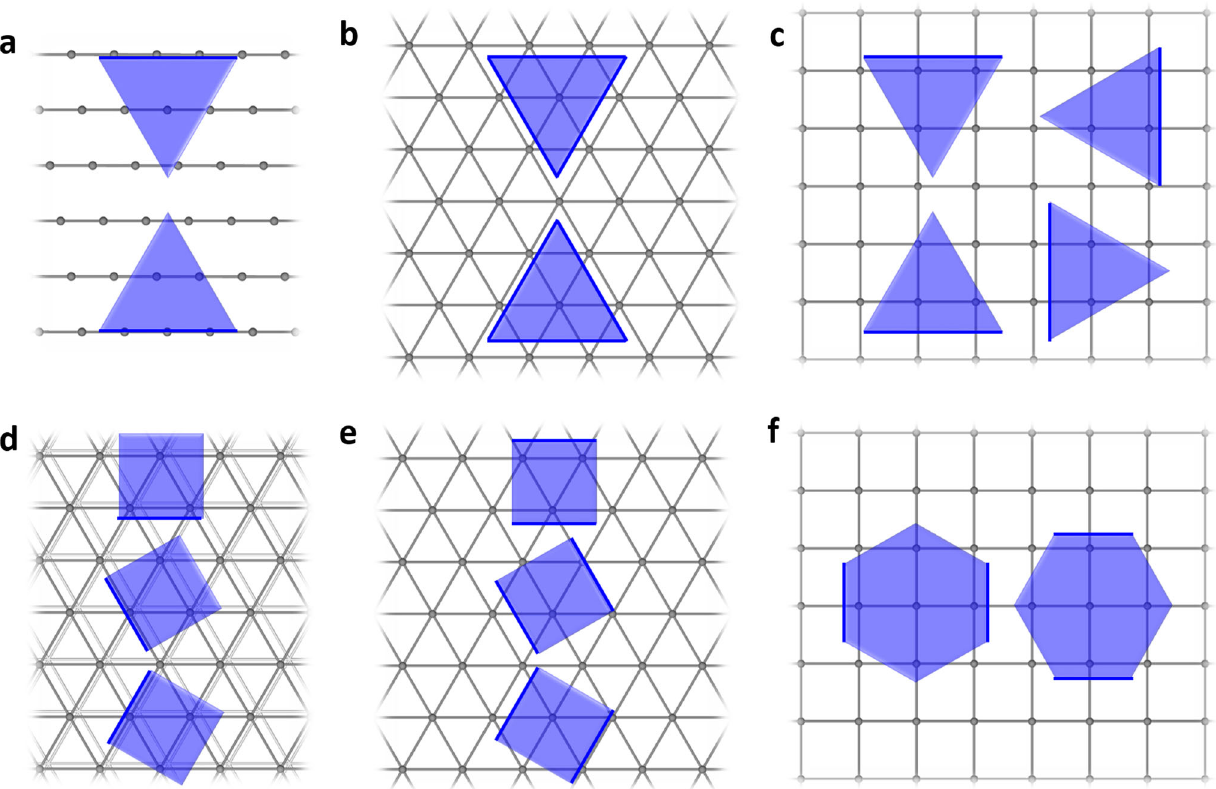
Fig. 1 Schematics showing the equivalent low-energy alignments of various 2D materials on substrates. a – c A threefold symmetric 2D material on a two-, six-, and four-fold symmetric substrate, respectively. d , e A fourfold symmetric 2D material on a three- and six-fold symmetric substrate, respectively. f A sixfold symmetric 2D material on a fourfold symmetric substrate. The 2D materials ’ edges that are preferentially aligned to the high symmetric directions of the substrates are